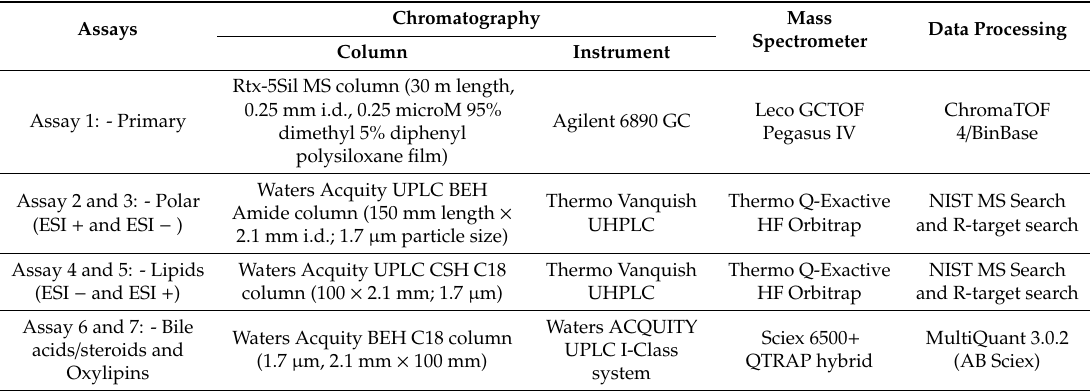
Table 1. Overview of the analytical